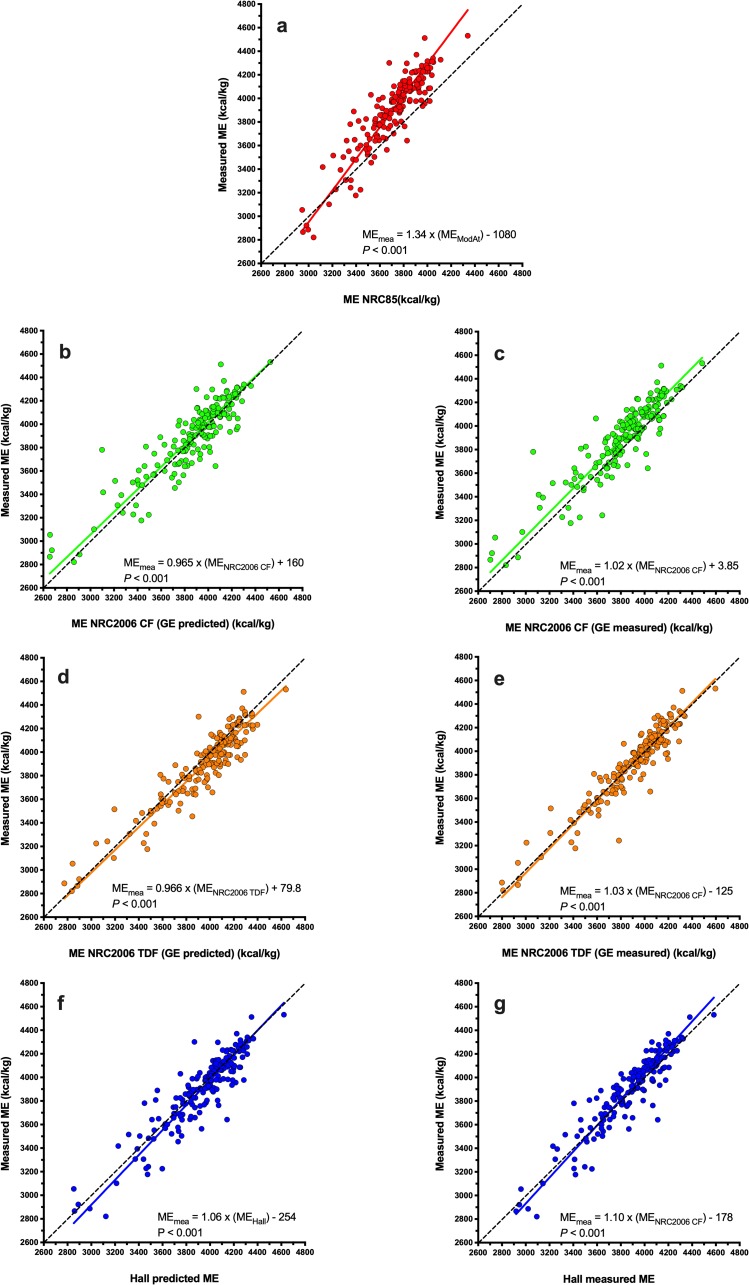
Deming regression plot depicting the relationship between measured and predicted metabolisable energy (ME) content in dry canine diets.The points represent results for individual foods, the solid line depicts the trendline from Deming regression, and the dotted black line represents the line of equivalence (where each unit increase in predicted ME equates to the same increase in measured ME. Different figures represent predictions made with MA (red, a), NRC 2006cf (green, b: predicted GE; c: measured GE), NRC 2006tdf (orange; d: predicted GE; e: measured GE), and Hall equations (blue; f: predicted GE; g: measured GE).